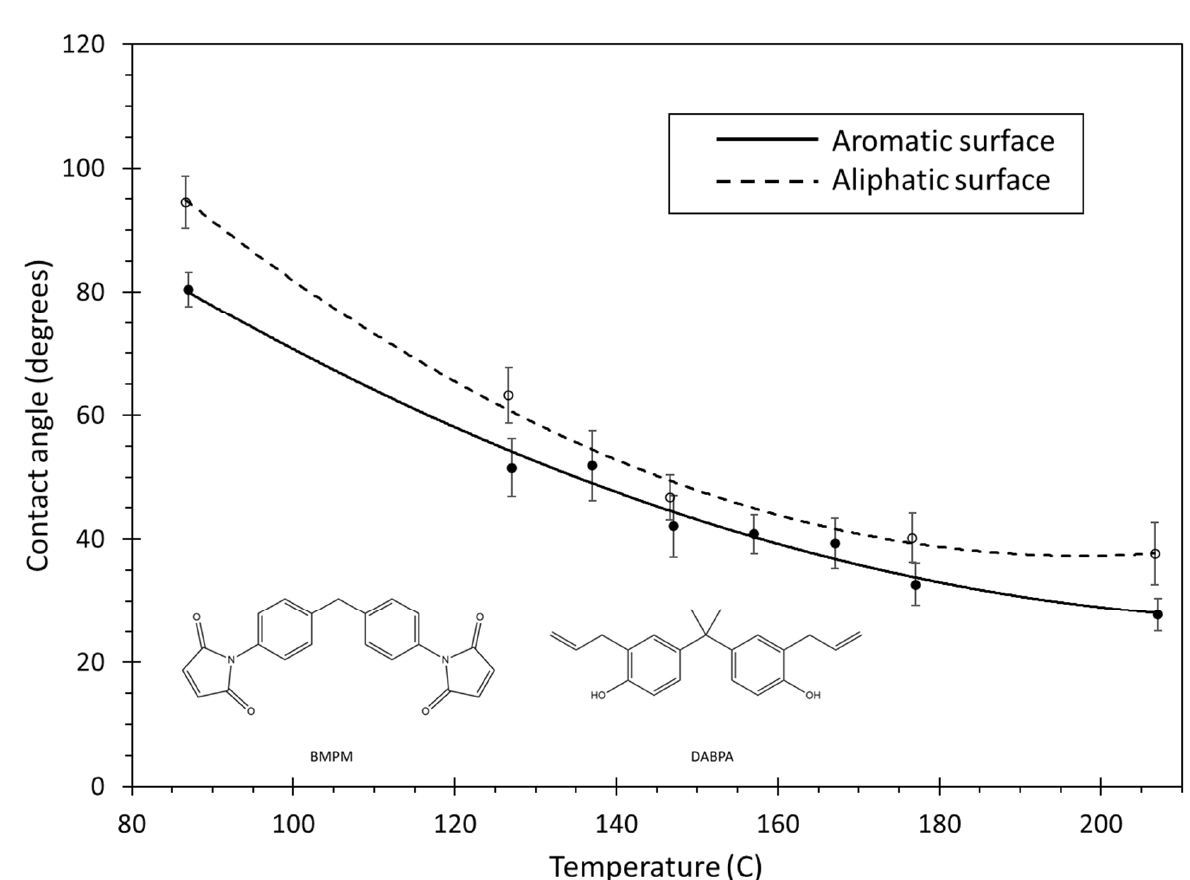
Figure 15. Plot of contact angle vs. temperature for BMI. The lines are curve fits to the data, and the error bars represent the standard error of replicate predictions.